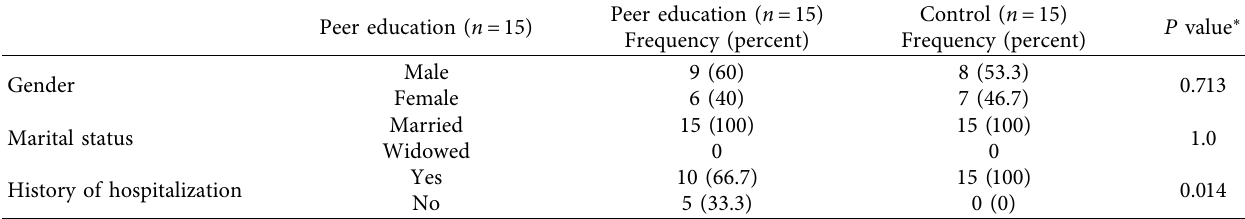
Table 1: Characteristics of the participants.